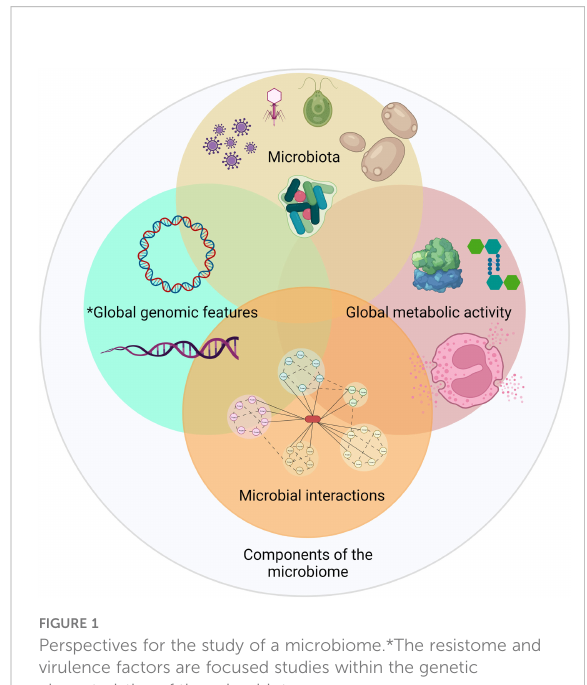
FIGURE 1 Perspectives for the study of a microbiome.*The resistome and virulence factors are focused studies within the genetic characteristics of the